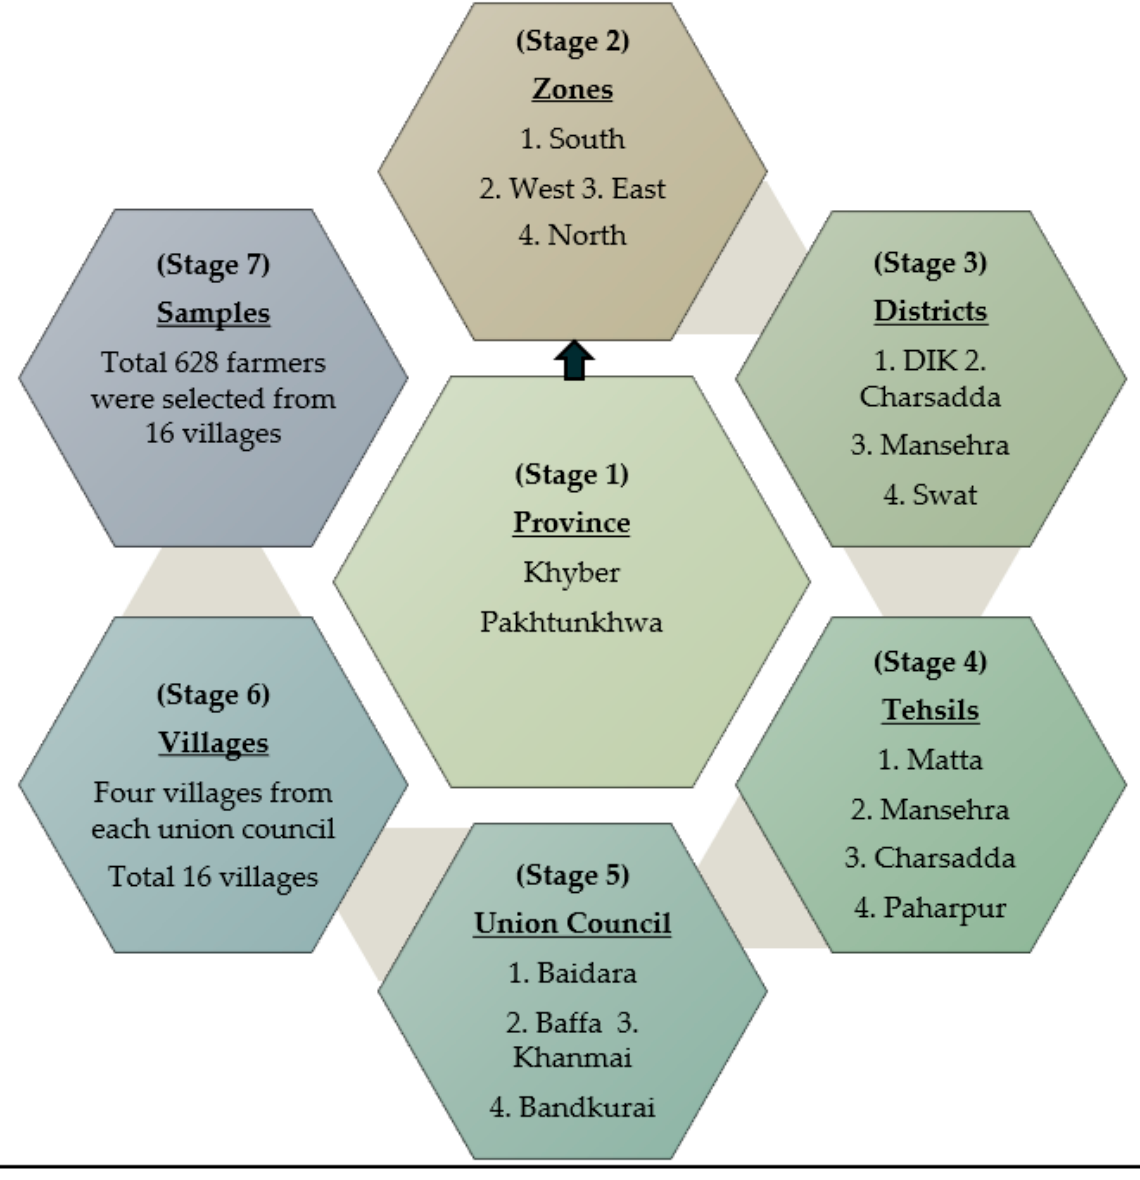
Figure 4. Sample distribution.